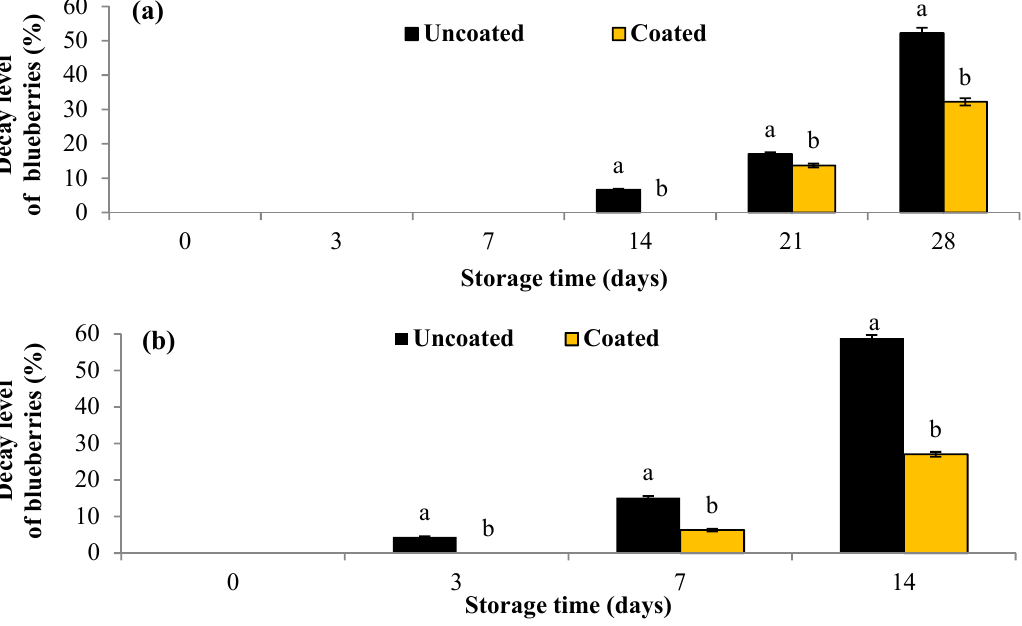
Figure 5. Evolution of the decay level (%) in pullulan coated blueberries during storage at 4 °C for 28 days ( a ); and at 16 °C for 14 days ( b ). Error bars represent the standard deviation. Values are means of three (n = 3) replications. Means with different letters amongst different treatments for the same time are significantly different according to Tukey’s test ( p < 0.05).